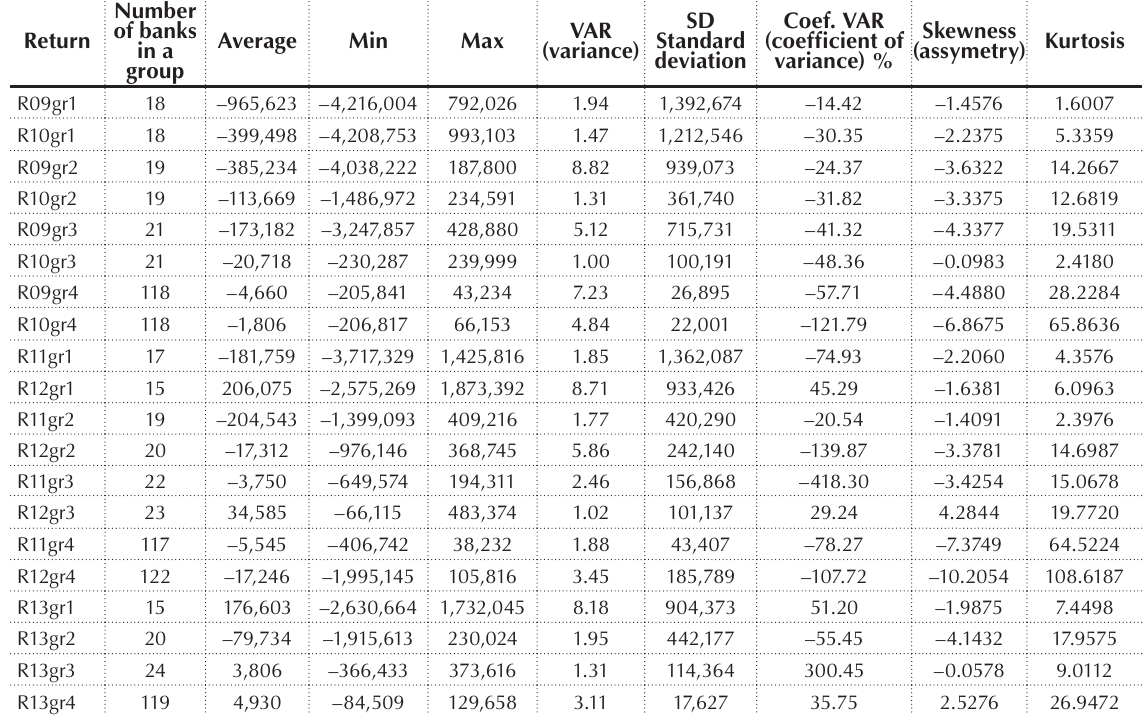
Table 3. (cid:115)(cid:258)(cid:396)(cid:349)(cid:258)(cid:374)(cid:272)(cid:286)(cid:400)(cid:3)(cid:381)(cid:296)(cid:3)(cid:396)(cid:286)(cid:410)(cid:437)(cid:396)(cid:374)(cid:400)(cid:876)(cid:367)(cid:381)(cid:400)(cid:400)(cid:286)(cid:400)(cid:3)(cid:381)(cid:296)(cid:3)(cid:104)(cid:364)(cid:396)(cid:258)(cid:349)(cid:374)(cid:349)(cid:258)(cid:374)(cid:3)(cid:271)(cid:258)(cid:374)(cid:364)(cid:400)(cid:3)((cid:271)(cid:258)(cid:400)(cid:286)(cid:282)(cid:3)(cid:381)(cid:374)(cid:3)(cid:336)(cid:396)(cid:381)(cid:437)(cid:393)(cid:400)(cid:3)(cid:258)(cid:272)(cid:272)(cid:381)(cid:396)(cid:282)(cid:349)(cid:374)(cid:336)(cid:3)(cid:410)(cid:381)(cid:3)(cid:69)(cid:17)(cid:104)(cid:3) (cid:272)(cid:367)(cid:258)(cid:400)(cid:400)(cid:349)(cid:302)(cid:272)(cid:258)(cid:415)(cid:381)(cid:374)(cid:895)(cid:3)(cid:282)(cid:437)(cid:396)(cid:349)(cid:374)(cid:336)(cid:3)(cid:410)(cid:346)(cid:286)(cid:3)(cid:455)(cid:286)(cid:258)(cid:396)(cid:400)(cid:3)(cid:1006)(cid:1004)(cid:1004)(cid:1013)(cid:884)(cid:1006)(cid:1004)(cid:1005)(cid:1007)